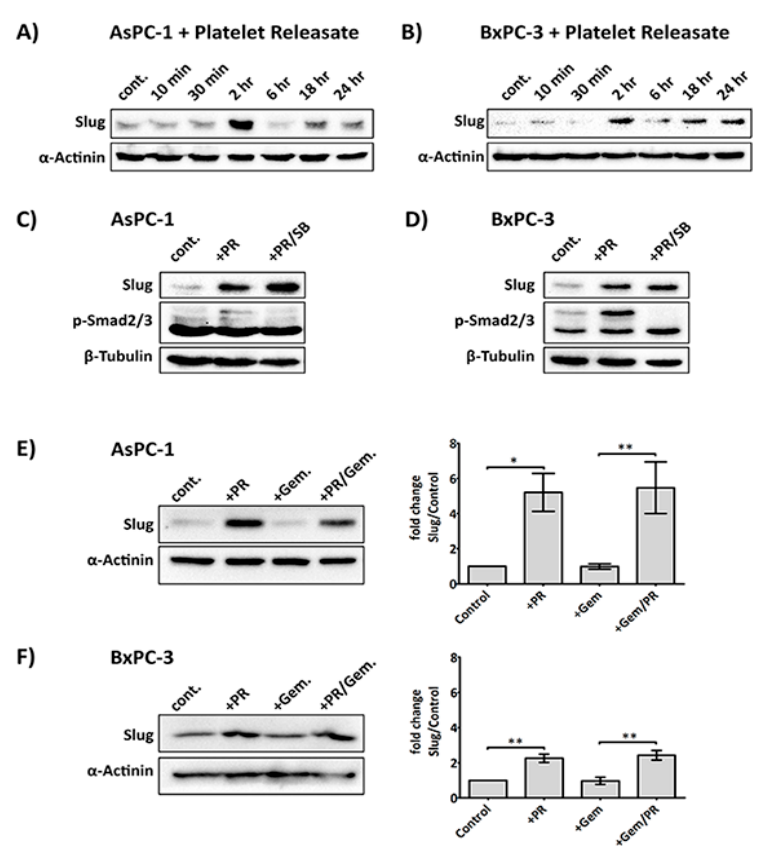
Figure 2. PR induces a rapid upregulation of Slug, an EMT and chemotherapy resistance marker, independent of the TGF β 1/Smad pathway. Representative immunoblots ( A ) and ( B ) show Slug expression in AsPC-1 and BxPC-3 cells after time course treatment with platelet releasate (PR). 2 × 10 5 cancer cells per well were seeded in a 12-well plate for 24 h, serum starved for 6 h, then PR was added to the culture media (final concentration of PR was equivalent to releasate from 5 × 10 8 platelets/mL) for 10 min, 30 min, 2 h, 6 h, 18 h and 24 h. Representative immune blots ( C ) and ( D ) show Slug and pSmad2/3 expression in AsPC-1 and BxPC-3 cells after treatment with PR ± 10 µM SB431542 (TGF β 1 receptor inhibitor) or 0.1%DMSO (vehicle control, Sigma-Aldrich, St. Louis, MO, USA) for 2 h. Cell lysates were separated by SDS-PAGE and immunoblotted using specific antibodies for Slug (upper panel), p-Smad2/3 (middle panel) and loading control protein α -actinin or β -tubulin (lower